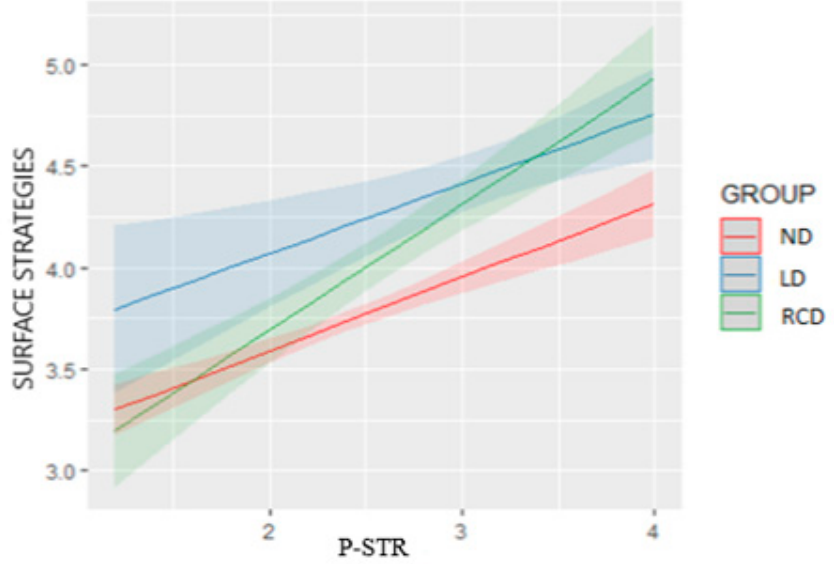
Figure 1. Interaction effect of P-STR and Groups on Surface Strategies.